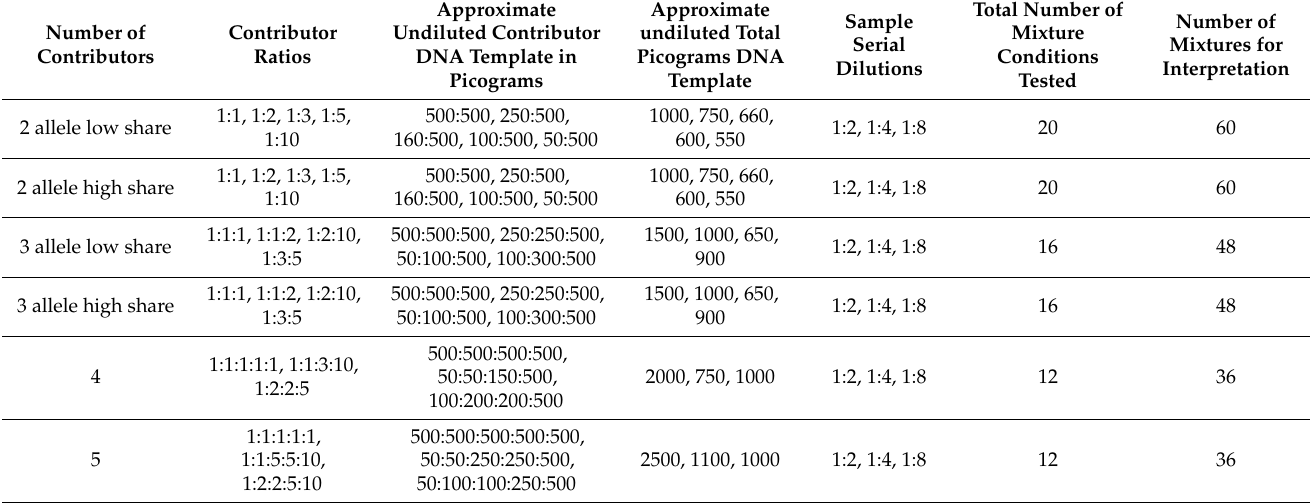
Table 2. Summary of mixture ratios, quantities, proportions, and dilutions analyzed with the MaSTR™ software. The approximate undiluted contributor DNA template in picograms indicates the quantity of DNA used to create the base (undiluted) mixture for each ratio. These mixtures were then serially diluted as indicated. The approximate quantity in picograms of specific contributors described in the paper is listed in the text where relevant. The approximate undiluted total picograms DNA template indicates all contributor template quantities added together for each of the ratios used. The total number of mixture conditions tested is the product of the number of ratios multiplied by the number of dilutions used (including undiluted). The number of mixtures for interpretation values reflect that each mixture condition was amplified in triplicate, yielding different peak heights for